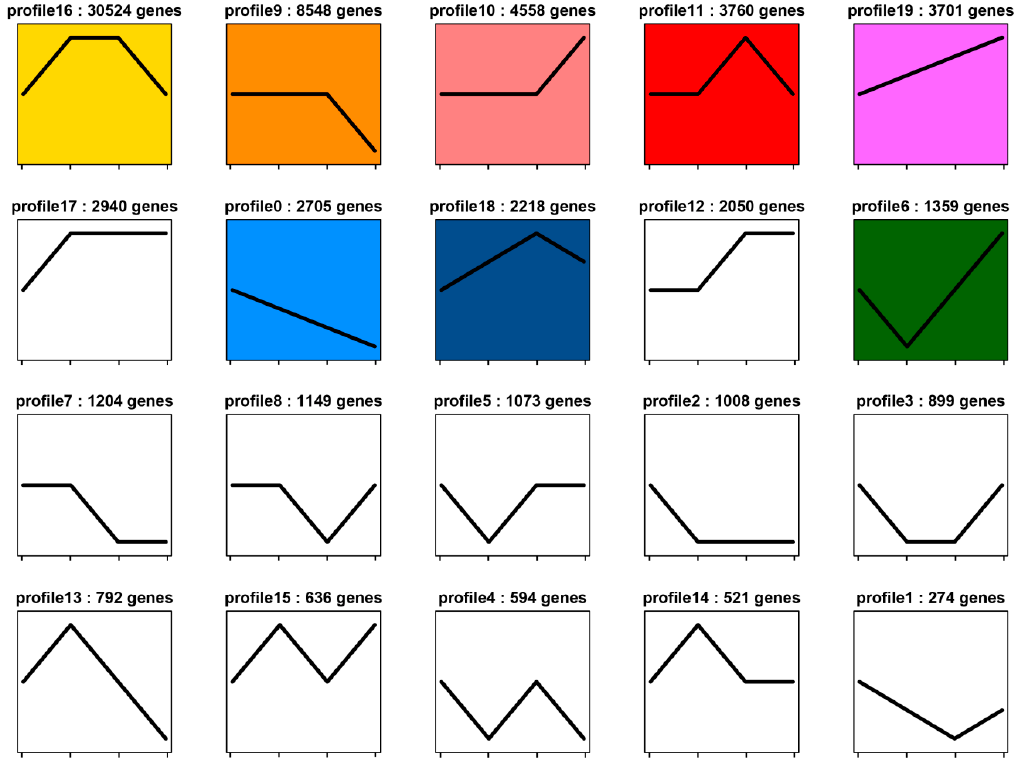
Figure 4. Expression patterns of the DEGs across LT, ES, SL, and WL stages of U. unicinctus . The x-axis represents the larval developmental stages, which are LT, ES, SL, and WL from left to right in each profile; the y-axis represents DEGs expression